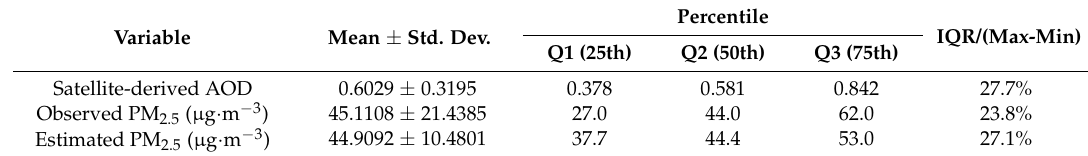
Variable Mean ± Std.